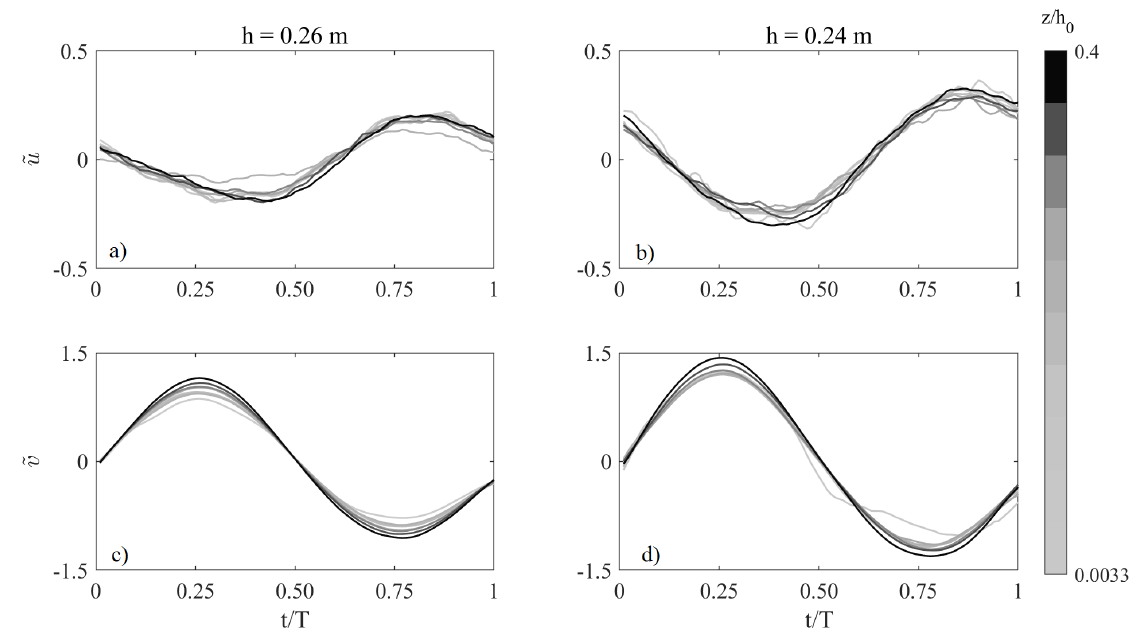
Figure 9. Phase-averaged velocities for tests 9 and 10 (WC, H = 0.085 m, T = 1.0 s) in the crosswise ( a , b ) and streamwise ( c , d ), with local water depth h = 0.26 m ( a , c ) and h = 0.24 m ( b , d ): U = 0.11 m/s ( a , c ) and U = 0.14 m/s ( b , d